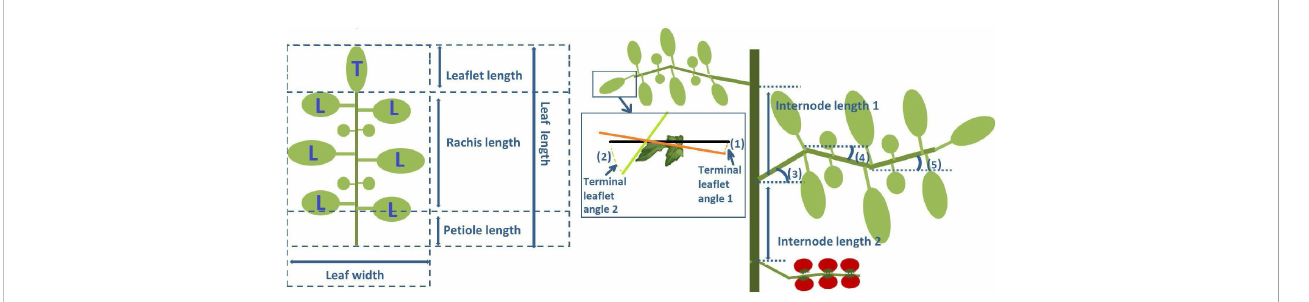
FIGURE 1 Diagram of measured plant architecture at the phytomer level. On the left side, a lea fl et with a terminal lea fl et (T) and six lateral lea fl ets (L). On the right- hand side, a stem section with two phytomers each containing an internode, petiole, and lea fl et. Indicated are (1, 2) a zoomed-in terminal lea fl et showing the measurement of terminal lea fl et angle 1 (from the base of the lea fl et to the middle point) and terminal lea fl et angle 2 (from the tip of the lea fl et to the middle point) relative to the horizon (3, 4, 5) petiole angle, fi rst rachis bend and second rachis bend which are all measured relative to the horizon, and internode lengths 1 and 2 of the two